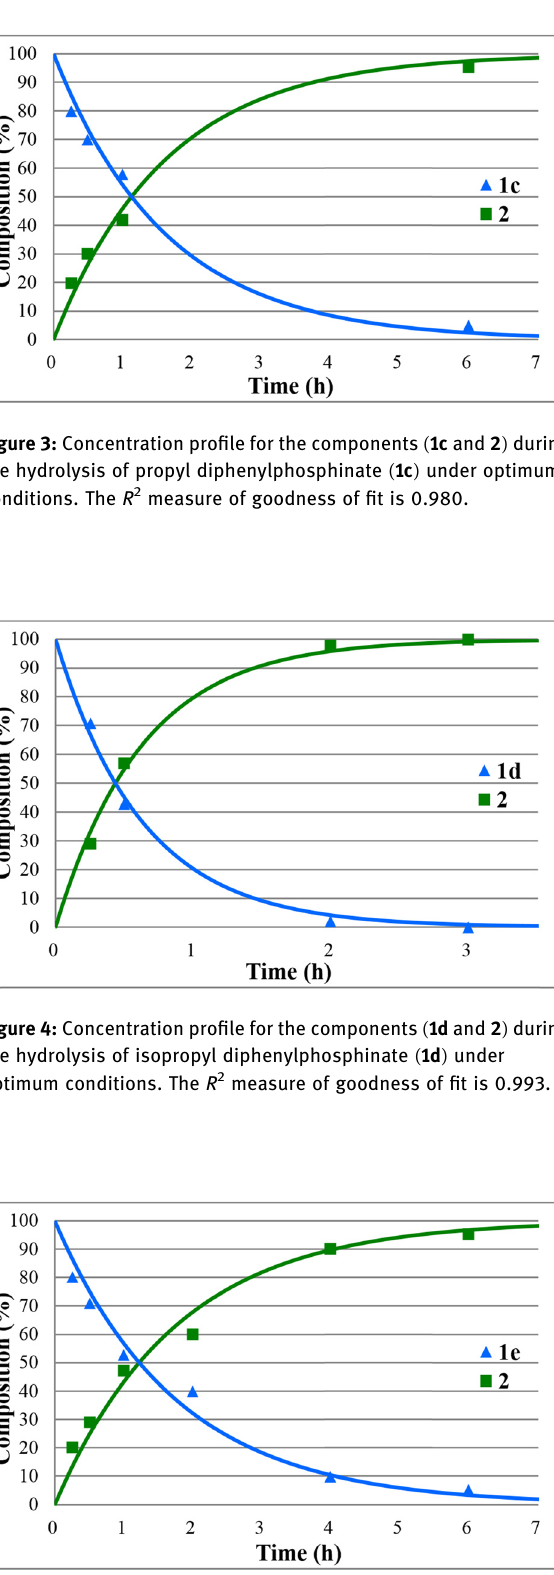
Figure 5: Concentration pro fi le for the components ( 1e and 2 ) during the hydrolysis of butyl diphenylphosphinate ( 1e ) under optimum conditions. The R 2 measure of goodness of fi t is